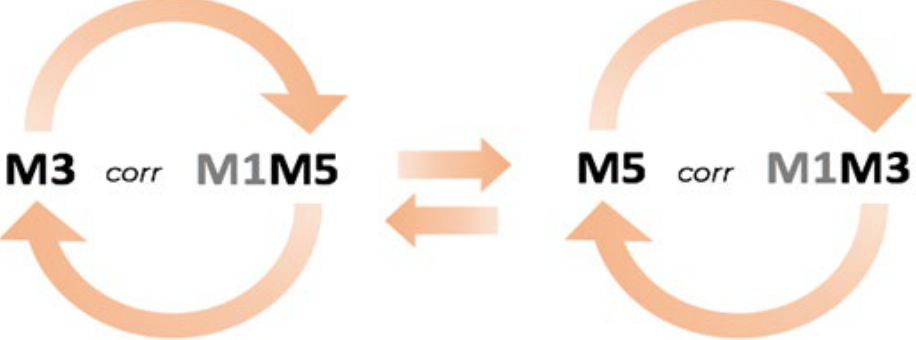
Figure 2. Example of “seesaw”-like behaviour. Methylated CpG 3 (M3) found as a single CpG is correlated with the multiplied pair of CpGs 1*5 (M1M5). In passing to the right, CpG 3 is interchanged with CpG 5; the latter now gets correlated as a single (M5) instead of CpG 3, and the former will now be found within the multiplied pair. CpG 1 remains to complete the triplet (M1M3).